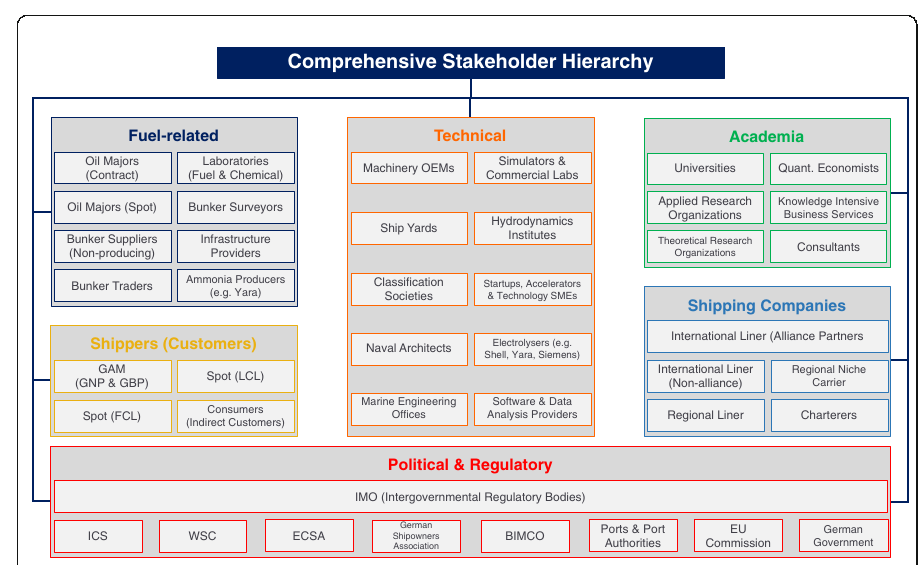
Fig. 6 Generic R&D Cooperation Assessment Model. Source: Own